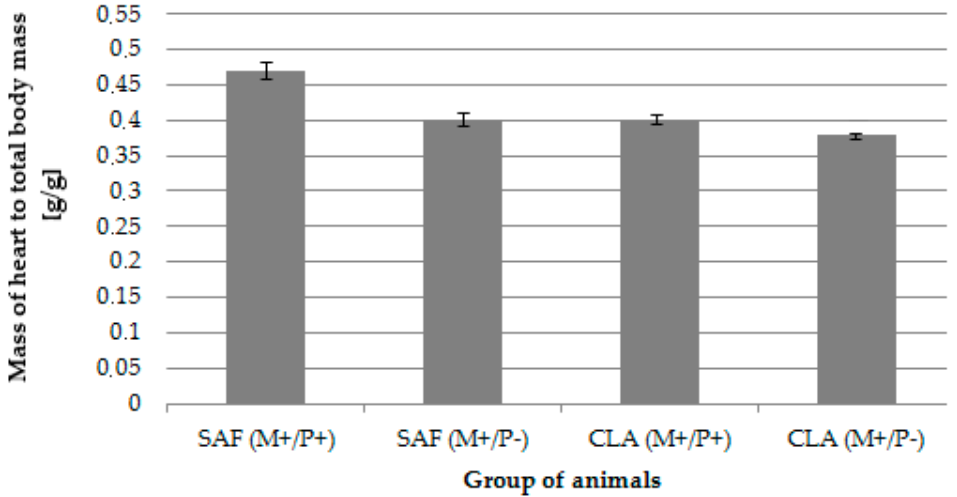
Figure 2. The relative mass of the hearts of offspring rats [g/g].